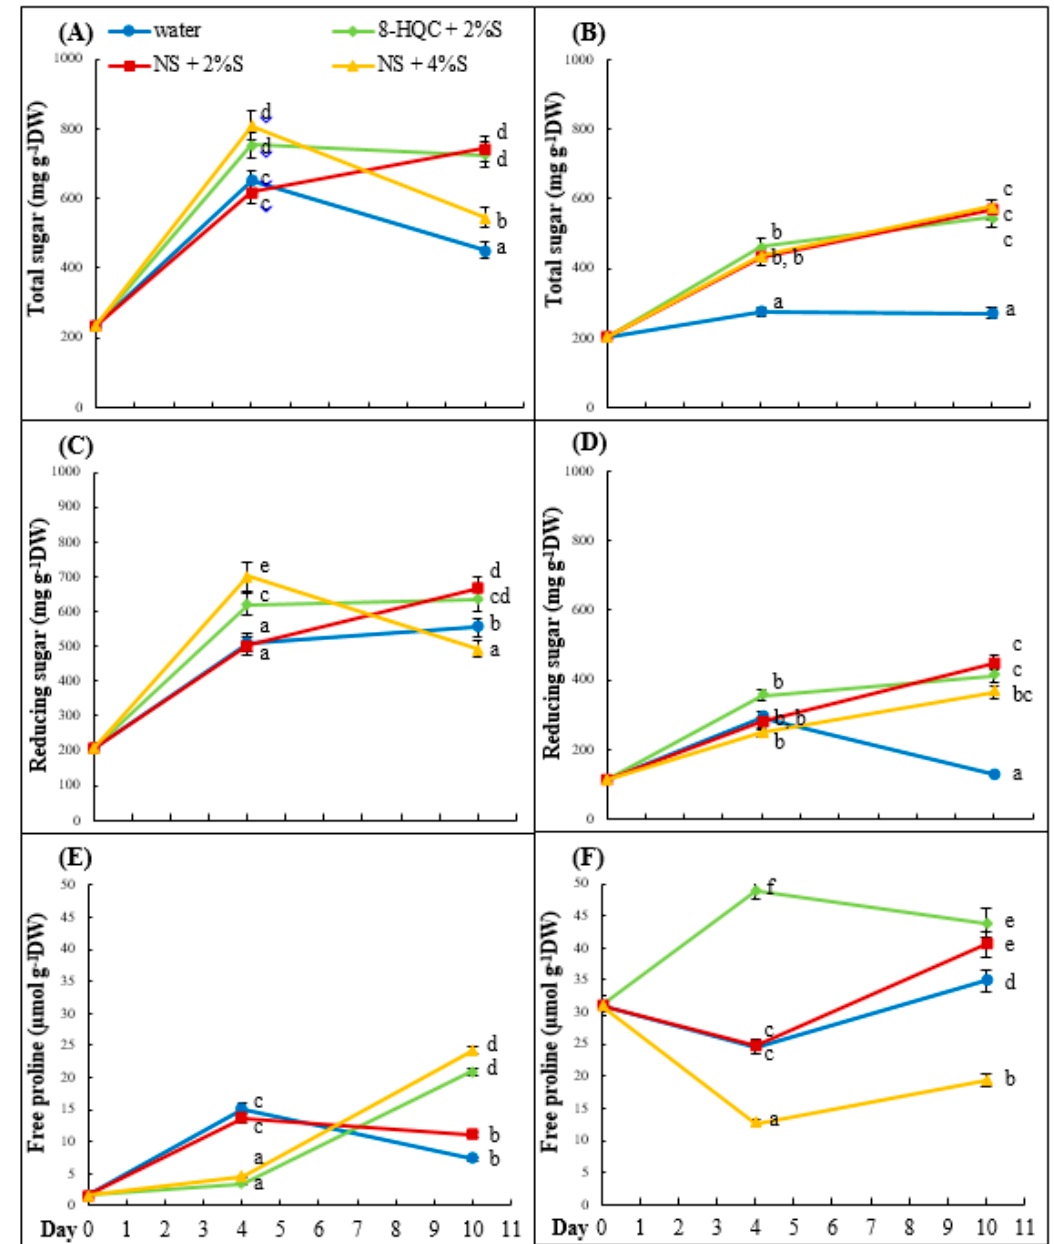
Figure 4. Total sugar content ( A , B ), reducing sugar content ( C , D ) and free proline content ( E , F ) in cut non-stored peony flowers ( A , C , E ) and in cut peony flowers after 12 weeks storage ( B , D , F ) during 10 days of vase life. Values are expressed as the mean ± SD of triplicate assays. Vertical bars represent standard deviations of the means. Means followed by the same lower case letter do not differ significantly at α = 0.05 (Duncan’s test). Analyses were done separately for non-stored and stored flowers.